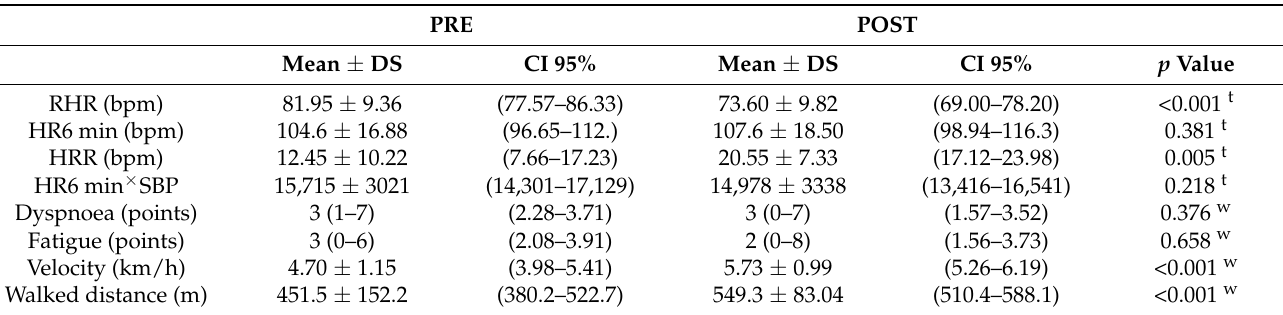
Table 4. Heart rate, perception and performance of the 6 MWT before and after a pulmonary rehabilitation